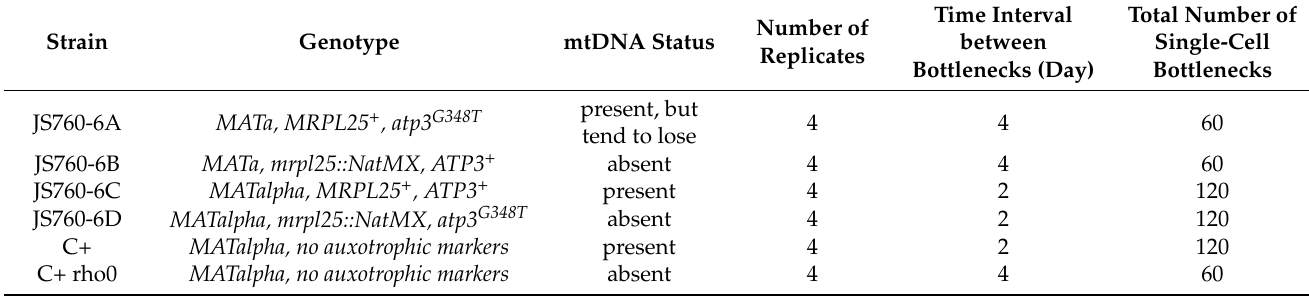
Table 1. Basic information of yeast strains and their mutation accumulation